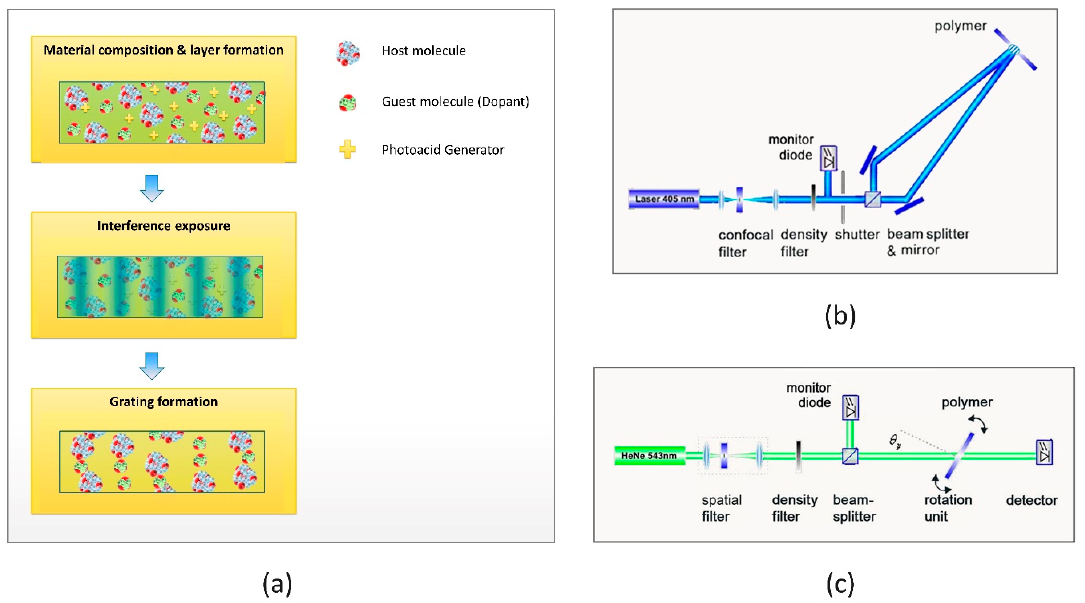
Figure 4. Overview on Materials and Methods: ( a ) Schematic illustration of composition, exposure, and grating formation for the host–guest material. ( b ) Holographic exposure setup with geometry for transmission gratings. ( c ) Rotation-scan setup.